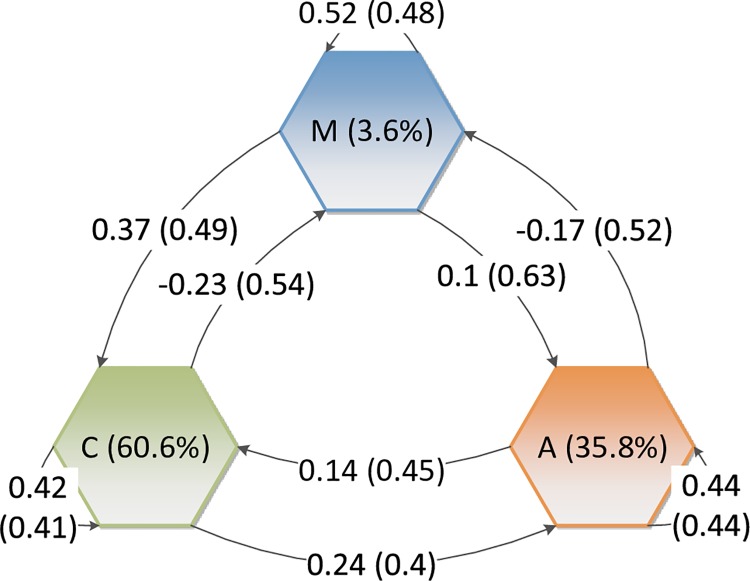
Attitudes of each group—Muslims (M), Christians (C), and areligious (A)—toward each other (averages and standard deviations in parentheses for each relation computed from the representative survey of the French population).Negative values represent the “unfavorable” attitudes. Positive values represent the “favorable” attitudes. The percentages in the middle of each hexagon is the percentage of people each group represents in the survey–it is close from their distribution in the French population: 3.6¨% for Muslims (M), 35.8% for areligious (A); 60.6% for Christians (C).